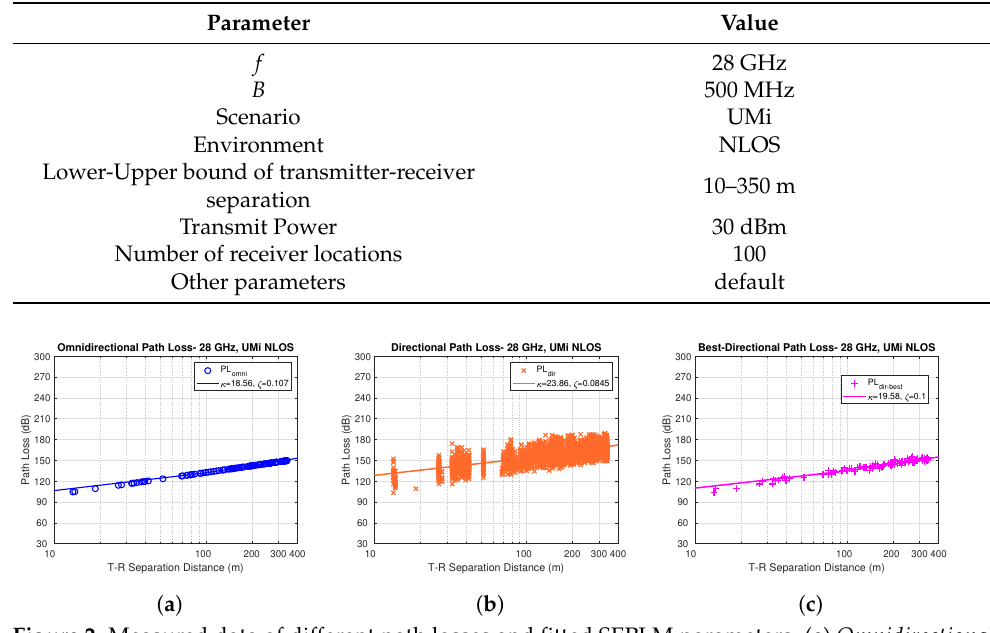
Figure 2. Measured data of different path losses and fitted SEPLM parameters. ( a ) Omnidirectional pathloss ( b ) Directionalpathloss ( c ) Best - directionalpathloss